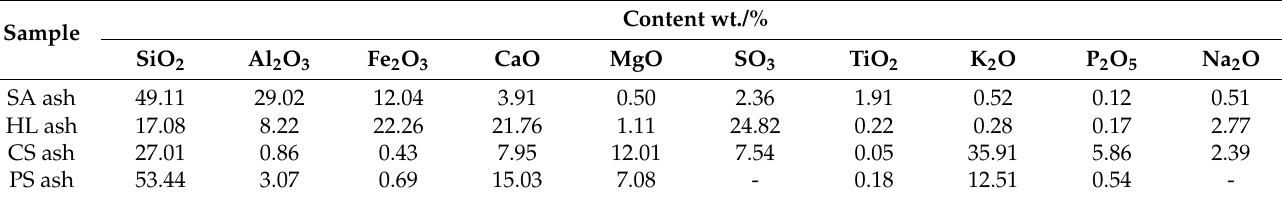
Table 2. Chemical compositions of tested ash sample